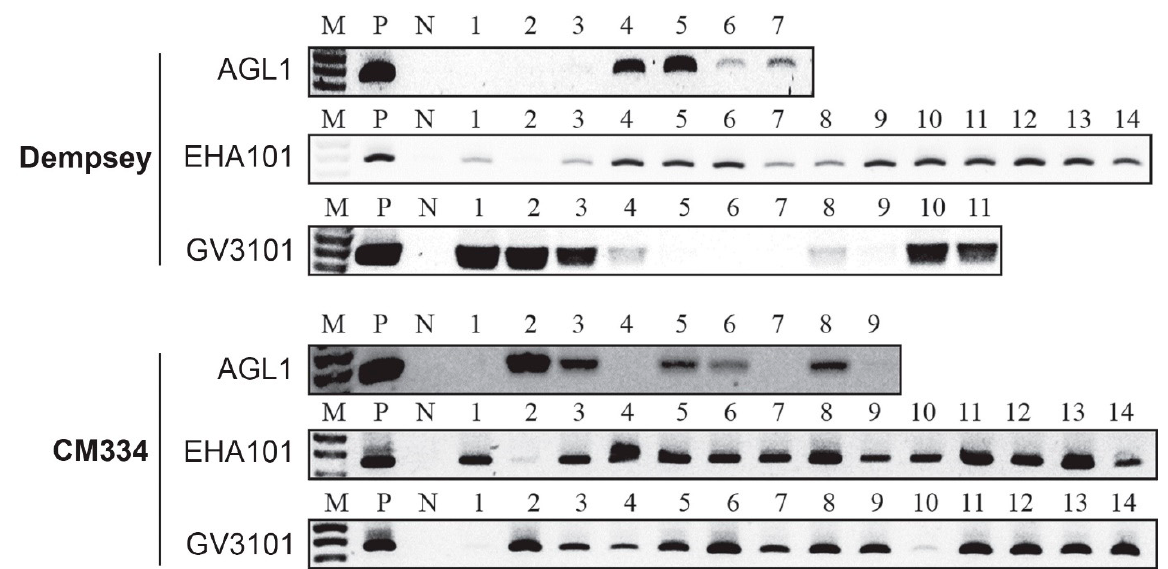
Figure 4. PCR analyses of PPT-selected and transformed calli of cv. Dempsey and CM334. ( a ) Calli in cv. Dempsey induced by Agrobacterium strain AGL1, EHA101, and GV3101, respectively; ( b ) calli in cv. CM334 induced by Agrobacterium strain AGL1, EHA101, and GV3101, respectively. M, 100-bp DNA ladder; P, pBAtC: CaMLO2 –sgRNA1 binary vector; N, non-transformed pepper callus. The indicated numbers (1 to 14) are the PPT-selected and transformed calli in cv. Dempsey and CM334.